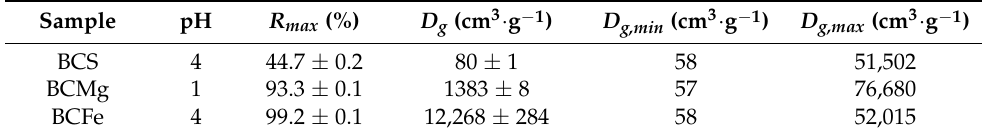
Table 7. Minimum and maximum D g values at which R reaches maximum.